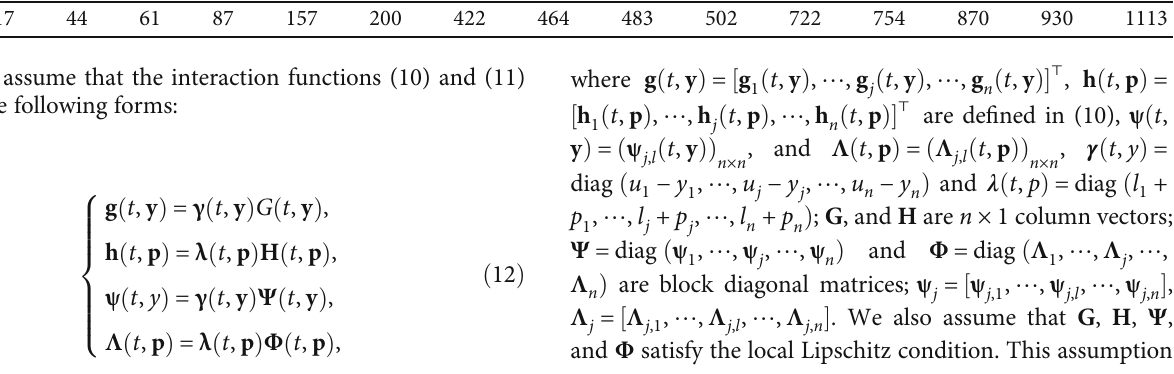
Figure 7: Real and simulated prices (without jump) for natural gas, crude oil, and coal. Table 6: Some result for the jump times of the system ( y , p